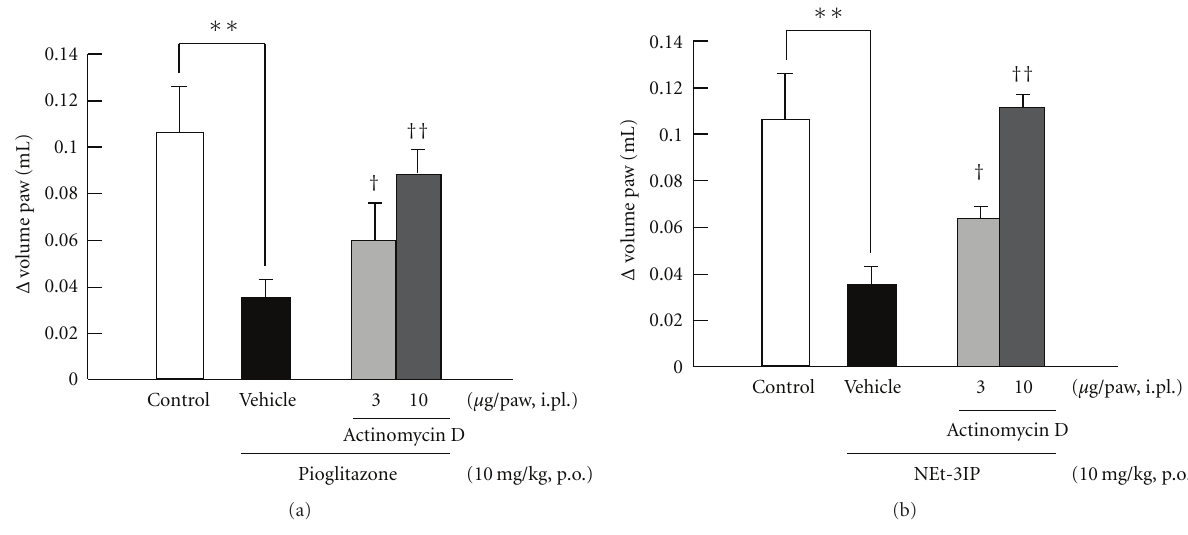
Figure 6: Influence of RNA polymerase inhibitor on PPAR γ agonist and RXR agonist-induced anti-inflammatory e ff ects . (a) E ff ect of RNA polymerase inhibitor, actinomycin D on pioglitazone-induced anti-inflammatory e ff ect. Pioglitazone was orally administrated 3h before carrageenan injection at a dose of 10mg/kg. Actinomycin D was injected 15min before carrageenan injection at doses of 3 and 10 μ g/paw. The vehicle group received physiological saline including 10% dimethylsulphoxide. (b) E ff ect of actinomycin D on NEt-3IP-induced anti-inflammatory e ff ect. NEt-3IP was orally administrated 3h before carrageenan injection at a dose of 10 mg/kg. Actinomycin D was injected 15min before carrageenan injection at doses of 3 and 10 μ g/paw. The vehicle group received physiological saline including 10% dimethylsulphoxide. Each column and vertical bar represents the means ± S.E.M. ( n = 7). ∗∗ : Significantly di ff erent from the control group at P < 0 . 01 (Dunnett’s test). † , †† : Significantly di ff erent from the vehicle group at P < 0 . 05 and P < 0 . 01, respectively, (Dunnett’s test).